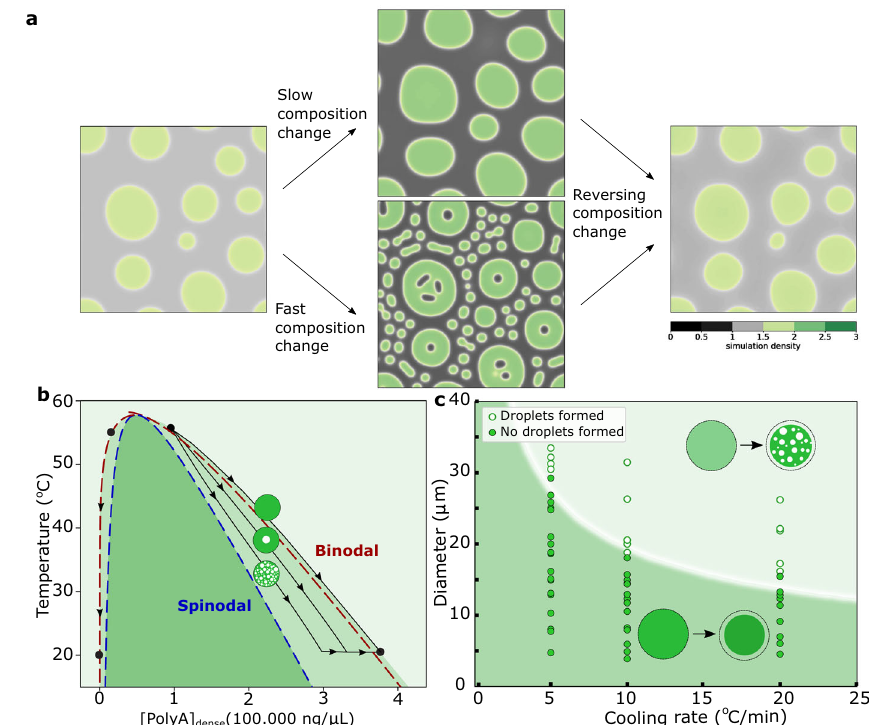
Fig.5|Theformationofdouble-emulsioncondensates.a Simulationsofrapidor slow composition changes provide evidence that the ability to form double- emulsion structures upon fast composition changes is a general. (Supplementary note 2, Supplementary movies 2, 3, 4 and 5). b Poly-rA PEG condensates change composition when they are cooled from 55to 20°C.Depending onfactorslike the rate of the change and the size of the condensate, the condensate can follow the binodal quite closely or deviate from the binodal, at which point biopolymer-poor